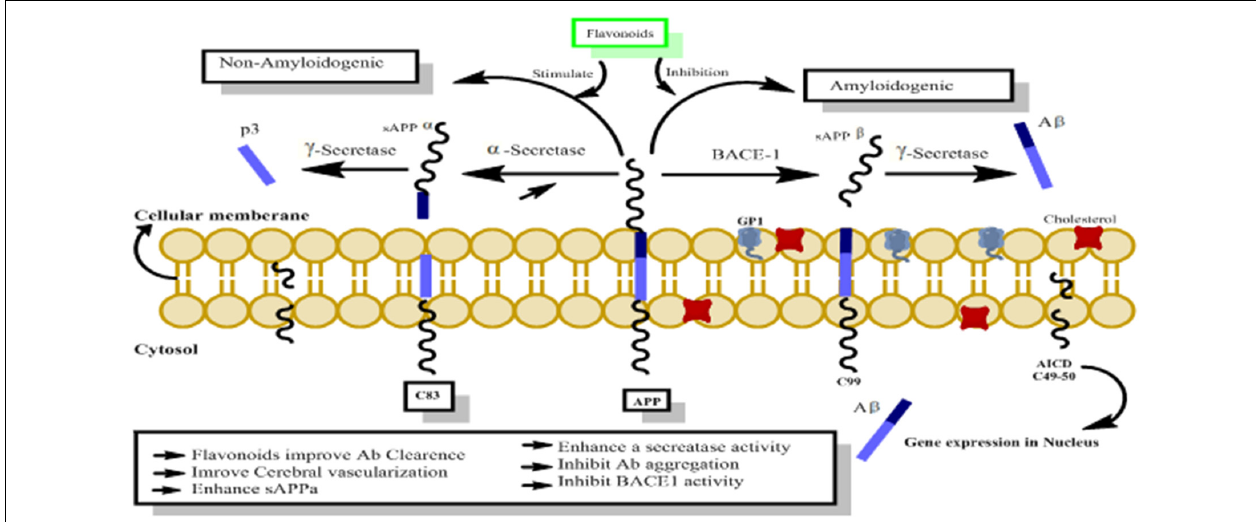
FIGURE 9 | The probable mechanism of flavonoids activating non-amyloidogenic pathway through stimulation of α , γ secretases activities, while inhibiting the neurotoxic amylogenic pathway by inhibition of BACE-1 enzyme.